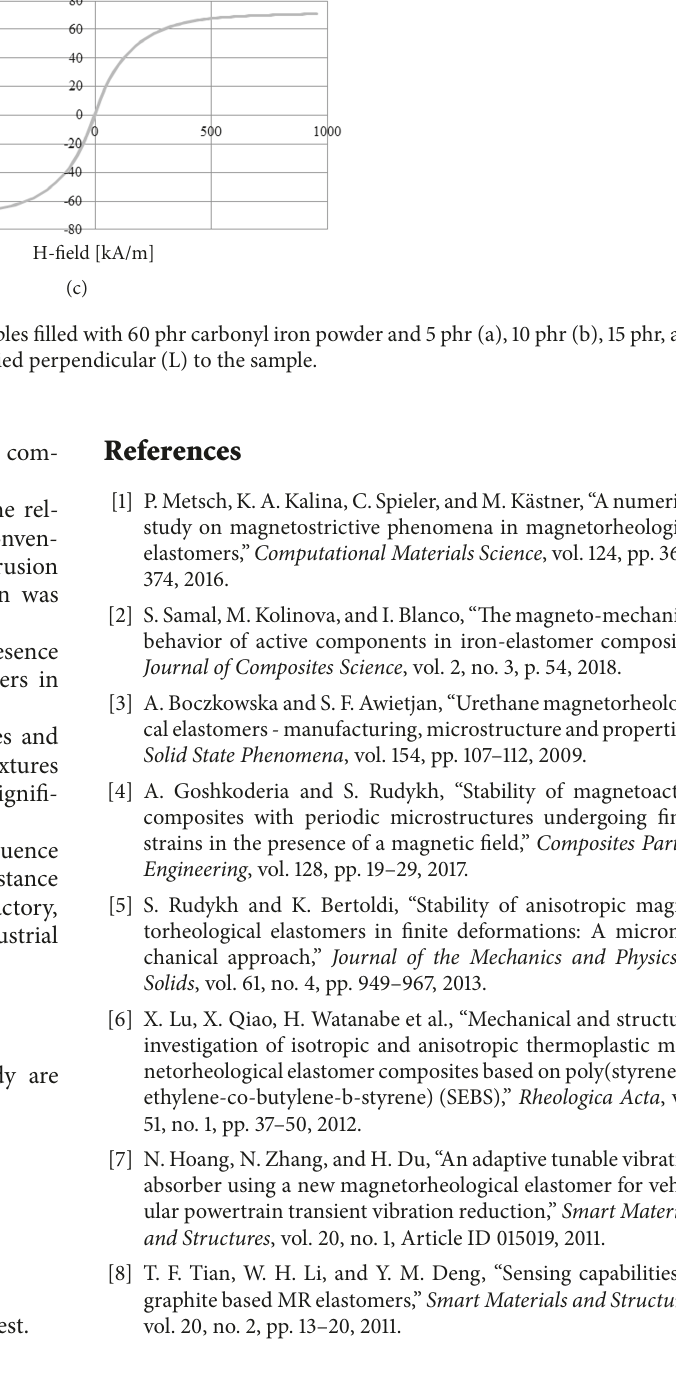
Figure 7: Magnetic properties–hysteresis loops of MRE samples filled with 60 phr carbonyl iron powder and 5 phr (a), 10 phr (b), 15 phr, and (c) carbon black cured under magnetic field (H) of 1,2T applied perpendicular (L) to the sample.